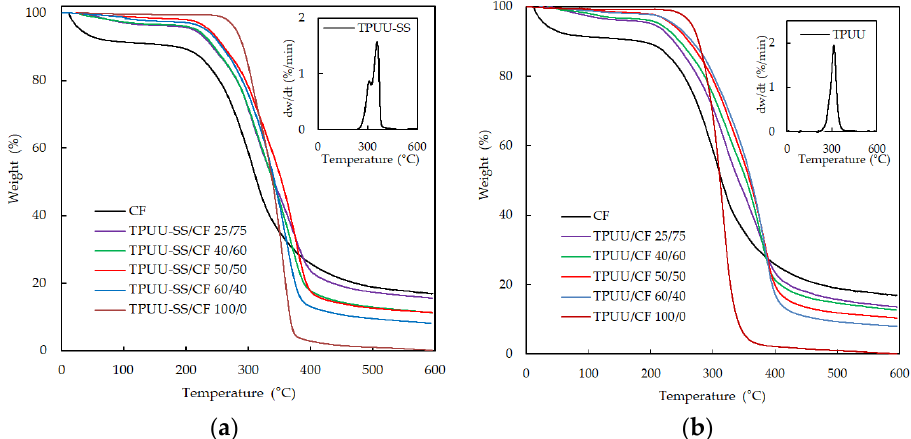
Figure 4. TGA curves of ( a ) TPUU-SS/CF and ( b ) TPUU/CF biocomposites containing different polymer/CF ratio and CF.